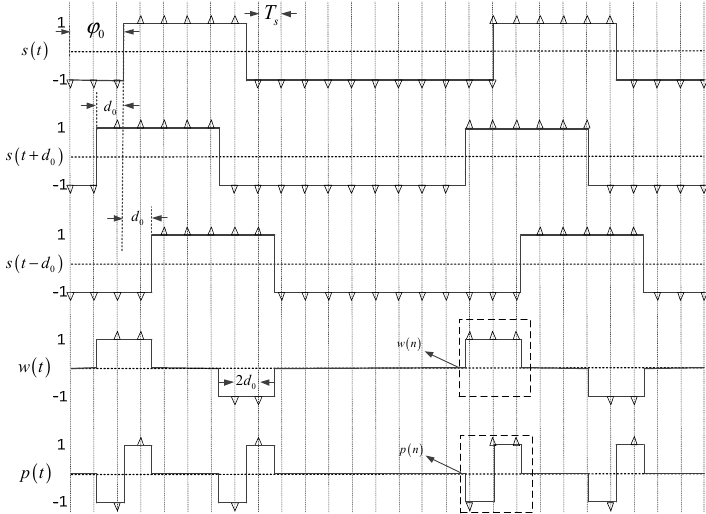
Figure 5. Schematic diagram of time domain sampling of local reference signals and equivalent reference waveforms.